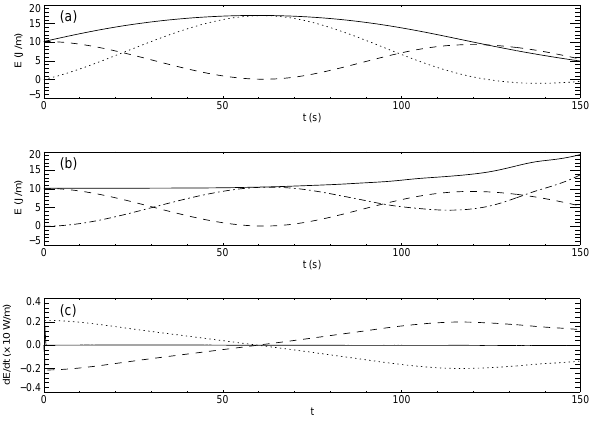
Fig. 16. Same as Fig. 15 except that surface current is in opposite